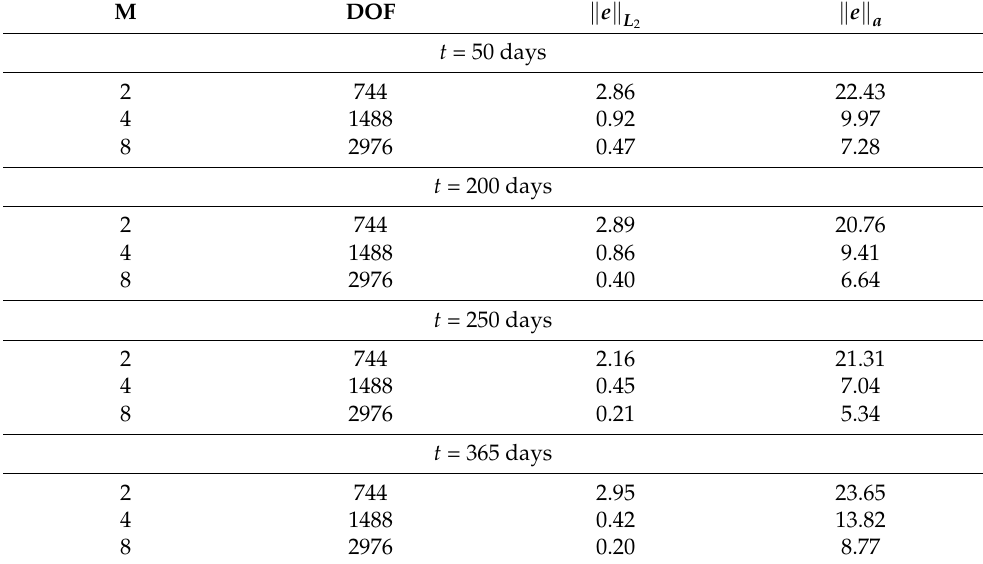
Table 4. Relative L 2 and energy errors (%) for different number of multiscale basis functions (DOF f = 172,681). Case 2: structured steel